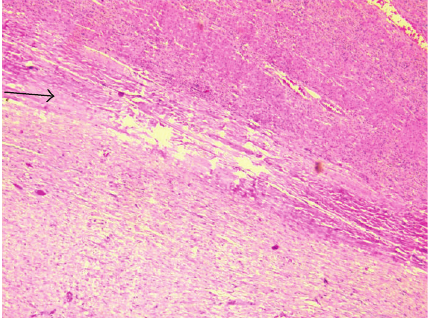
Figure 8: Photomicrograph showing fibrocollagenous septa (black arrow) separating the tumour from the adjacent liver parenchyma (10x